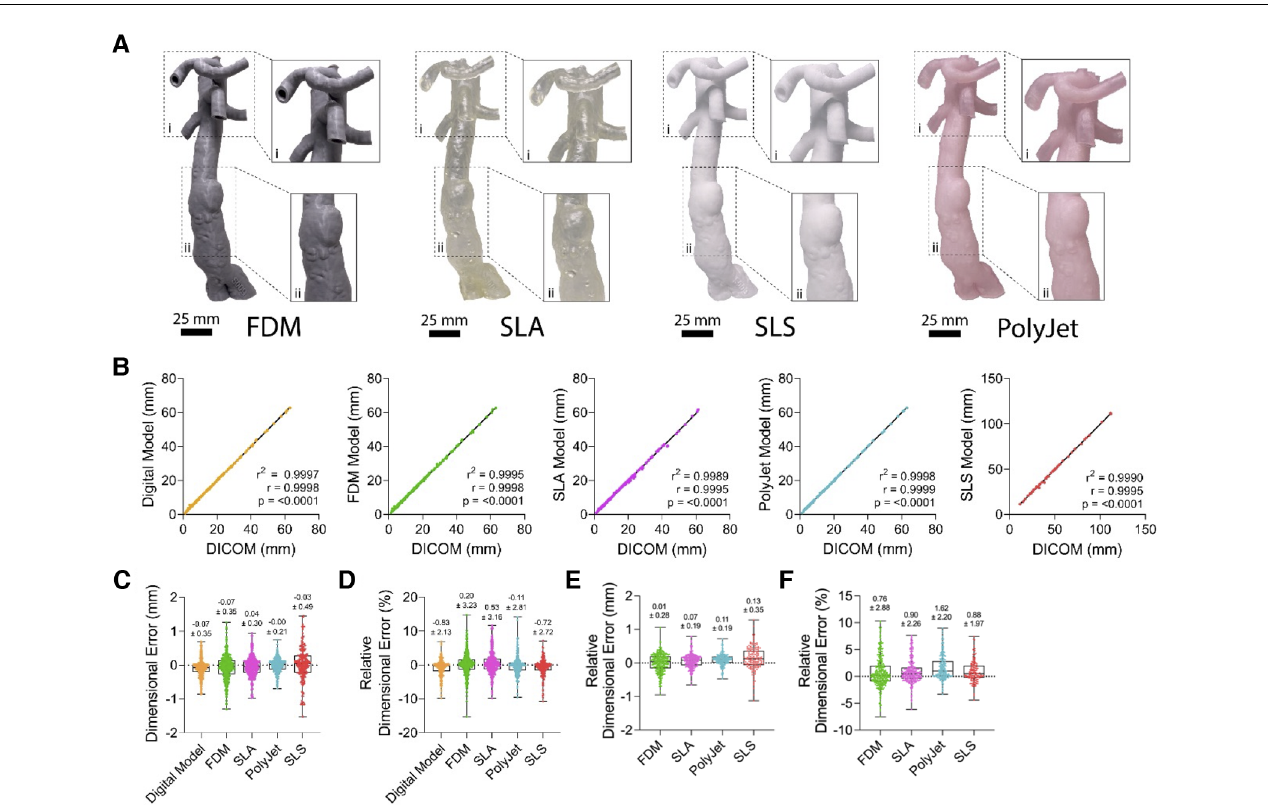
FIGURE 3 Gross morphological appearance and dimensional accuracy of vascular M3DP models. ( A ) Gross appearance of M3DP models printed using FDM, SLA, SLS, and POLYJET, respectively. ( B ) Dimensional correlation, ( C ) absolute and ( D ) relative error of digital and 3D-printed models compared to unmodi fi ed clinical imaging datsets (DICOM), ( E ) absolute and ( F ) relative error of 3D-printed models compared to digital